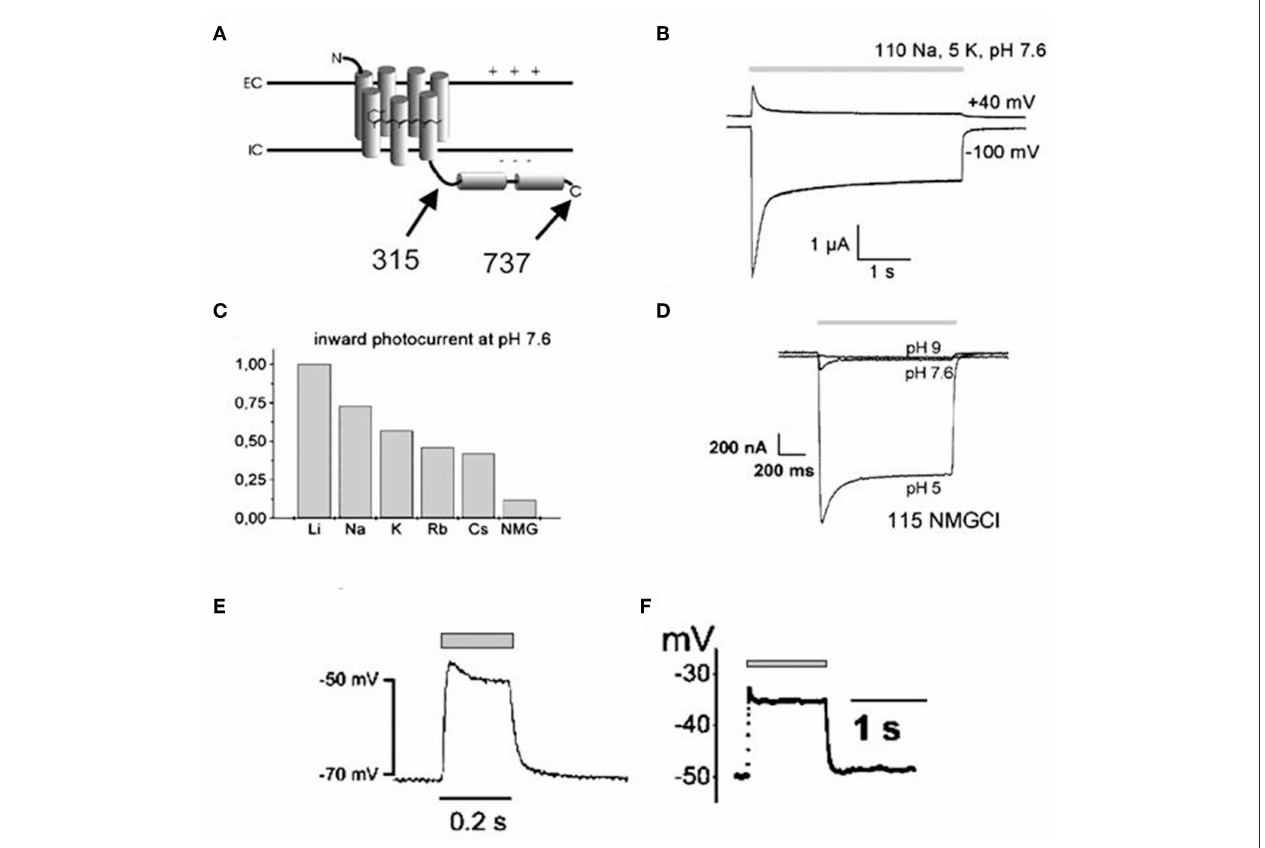
FIGURE 1 | Illustrations showing structural topology of Channelopsin-2 (Chop2) and the dependency of light-induced currents of Channelrhodopsin (ChR2) on both cellular microenvironment and illumination parameters. Both variants of Chop2, full length Chop2-737 and truncated Chop2-315 (A) , elicited large photocurrents upon light stimulation when expressed in oocytes. The channel desensitizes during continuous blue light illumination (450 ± 25nm), evidenced by the decay of the photocurrent to a steady-state level (B) , magnitude and direction of the photocurrent varies with the membrane potential (B) , magnitude of photocurrents also differs when kept in solution of different cations (C) , magnitude of photocurrent also depends on the extracellular pH (D) , and depolarization of cell membrane (millivolt) can be achieved rapidly upon photosensitization with blue light illumination both in oocytes (E) and HEK293 cells (F) . Reproduced with permission from Nagel et al. (2003) and Chang Liao et al.